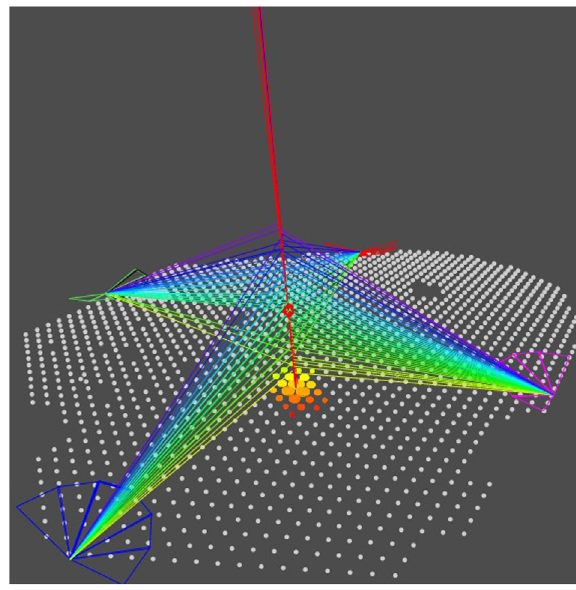
Figure 2. Representation of an event reconstructed by the Pierre Auger Observatory hybrid detection technique. The white dots corresponds to the WCD making up the SD, with the colored ones being the WCD activated by the shower. The four polygons around the SD are the buildings where the fl uorescence telescopes are located and the straight red line is the axis of an EAS hitting the